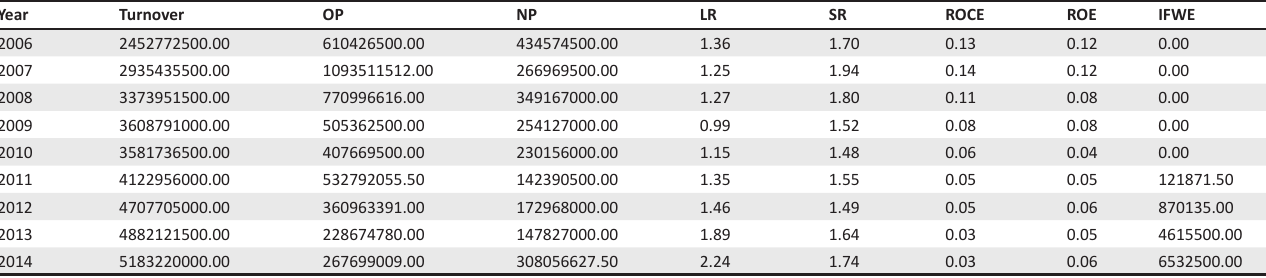
TABLE 5: Company performance measures medians. Year Turnover